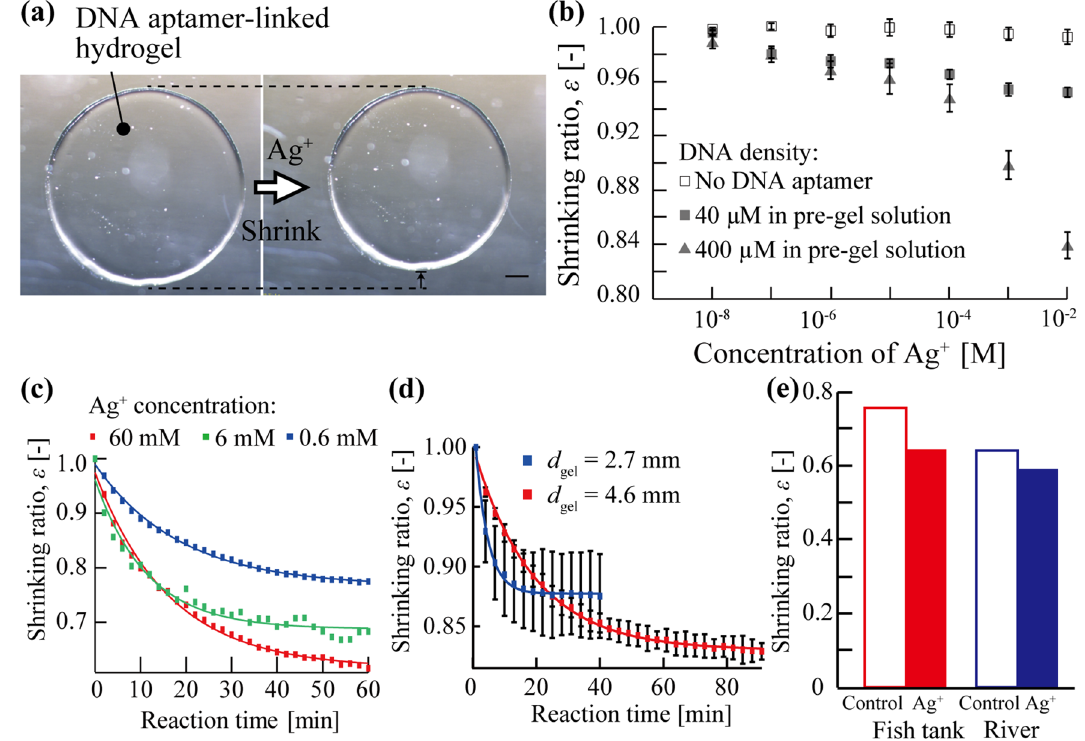
Figure 2. ( a ) The volume change of the DNA aptamer-linked hydrogel when applying the 10 mM Ag + ions. The scale bar is 500 µm. ( b ) The relationship between the shrinking ratio of DNA aptamer-linked hydrogels and the varied Ag + ion concentrations. ( c ) The time variation of the shrinking ratio, ε , at different Ag + ion concentrations. ( d ) The time variation of the shrinking ratio, ε , for the DNA aptamer-linked hydrogels with different sizes. ( e ) The detection of Ag + ions in the environmental modified with Methacrylic Acid N-Succinimidyl Ester to cross-link with the acrylamide network. To fabricate the DNA aptamer sensor, a pre-gel solution (0.20 g/mL Acrylamide, 0.133% (w/w) N , N ’-methylenebis (acryla- mide) as a cross-linker, 0.5% (v/v) Irgacure1173 as a photoinitiator, and Ag + -ion DNA aptamer (0, 40, 400 µM in pre-gel solution)) were poured in a poly-dimethylsiloxane (PDMS) molds (Diameter: d m = 3 mm, Thickness: t = 0.5 mm or Diameter: d m = 2 mm, Thickness: t = 0.3 mm), then cross-linked by UV irradiation. Finally, the fabricated DNA-aptamer linked hydrogels were placed in the pure water over 3 h for swelling by absorbing the surrounding pure water. Firstly, we verified the shrinking behavior of DNA aptamer-linked hydrogel to Ag + ions. The diameters of fab- ricated DNA aptamer-linked hydrogel, d gel , were 4.6 mm when we used the mold with 3-mm diameter: d m = 3 mm and the thickness: t = 0.5 mm (Fig. 2a left). When immersing the DNA aptamer-linked hydrogel into CH 3 COOAg solution for applying the 10 mM Ag + ions, the DNA aptamer-linked hydrogel (DNA aptamer: 400 µM in the pre-gel solution) successfully shrank (Fig. 2a right). On the other hand, the pure acrylamide hydrogel (no DNA aptamer) did not respond to any concentration of Ag + ions (Fig. 2b, white square). These results showed that the shrinking of hydrogel was caused by the DNA aptamer. Thus it is also considered that the DNA aptamer was specifically bound to the Ag + ions and changed their structure to the hairpin structure. Secondly, the applied Ag + -ion concentration was varied from 10 −5 to 10 mM for observing the influence of the Ag + -ion concentration on the shrinking ratio of the DNA aptamer-linked hydrogel. The DNA aptamer-linked hydrogel shrunk isotropically 19 . The shrinking ratio, ε , was defined as